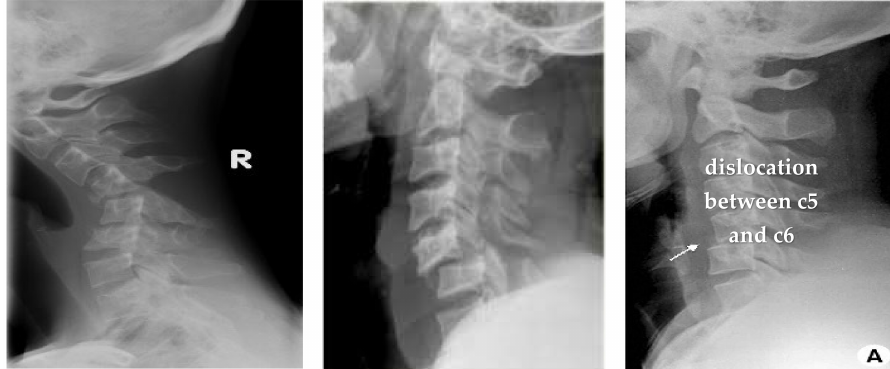
Figure 13. X-ray images for the dislocated CS.